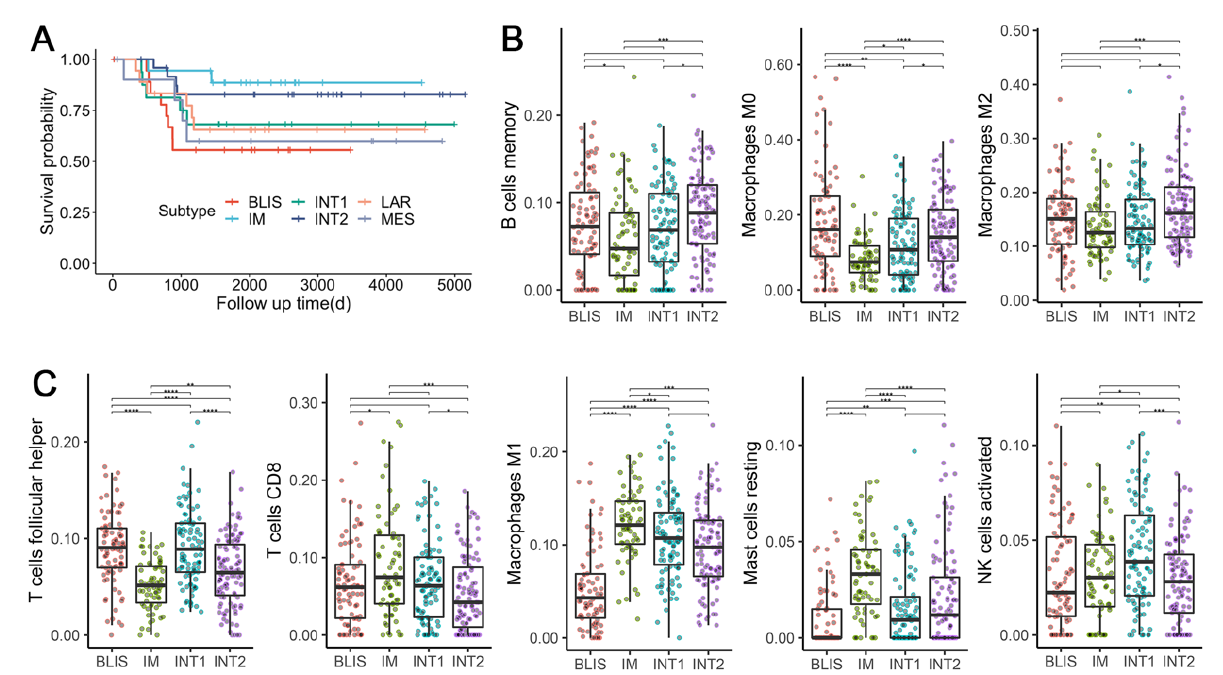
Figure 5. Prognostic differences and immune infiltration patterns of the 6 discovered subtypes. ( A ) The Kaplan–Meier survival curve with MFS from dataset GSE103091. ( B ) Immune infiltration scores of pro-tumorigenic cells among 4 basal-like subtypes. ( C ) Immune infiltration scores of anti- tumorigenic cells among 4 basal-like subtypes. The scores denote the immune cell abundance of the sample. Significance levels are labeled with asterisks (****, p < 0.0001; ***, 0.0001 < p < 0.001; **, 0.001 < p < 0.01; *, 0.01 < p < 0.05).